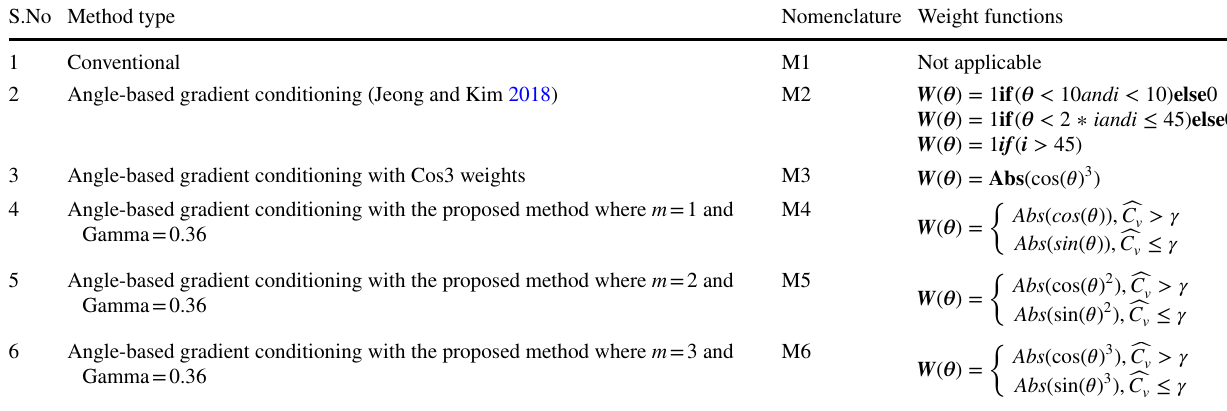
Fig. 2 Illustration of the initial velocity model used for the proposed workflow Table 1 Summary of weight functions for different angle-based gradient